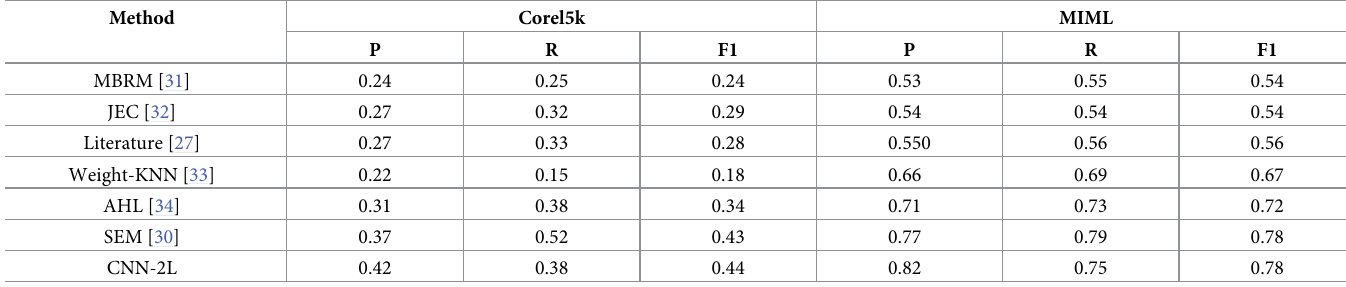
Table 3. Experimental comparison of various automatic image-labeling